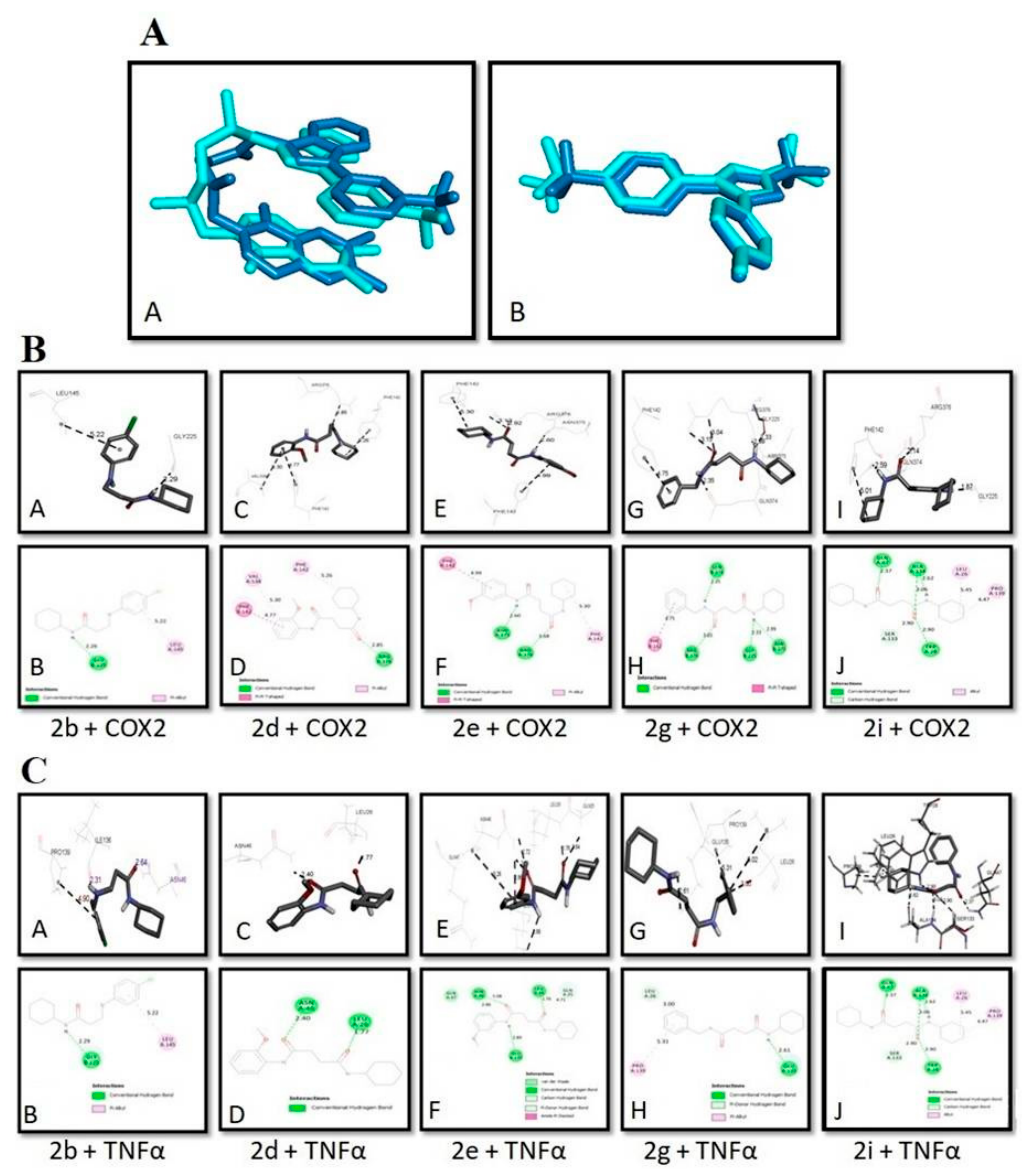
Figure 4. Best binding pose for 6,7-dimethyl-3-[(methyl{2-[methyl({1-[3(trifluoromethyl)phenyl]-1h-indol -3-yl} methyl)amino]ethyl}amino)methyl]-4h-chromen-4-one and celecoxib in the binding pockets of and tumor necrotic factor (TNF- α ) and cyclooxygenase-2 (COX-2) respectively (dark-blue = co-crystallized ligand, cyan = re-docked ligand) ( A , B ).( B ) Post dock analysis performed through Biovia Discovery StudioVisualizer illustrating both 2D and 3Dposes. Interactions between 2b and COX2 ( A , B ), 2d and COX2 ( C , D ), 2e and COX2 ( E , F ), 2g and COX2 ( G , H ), and 2i and COX2 ( I , J ). ( C )Post docking analysis visualized by Discovery Studio Visualizer in both 2D and 3D styles. Interactions between 2b and TNF- α ( A , B ), 2d and TNF- α ( C , D ), 2e and TNF- α ( E , F ), 2g and TNF- α ( G , H ), and 2i and TNF α ( I , J )